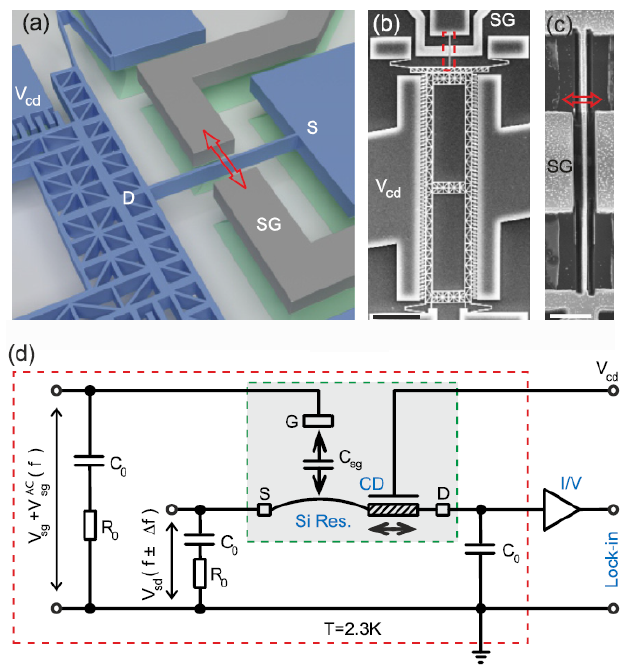
Figure 3: Tunable mechanical coupling between driven microelectromechanical